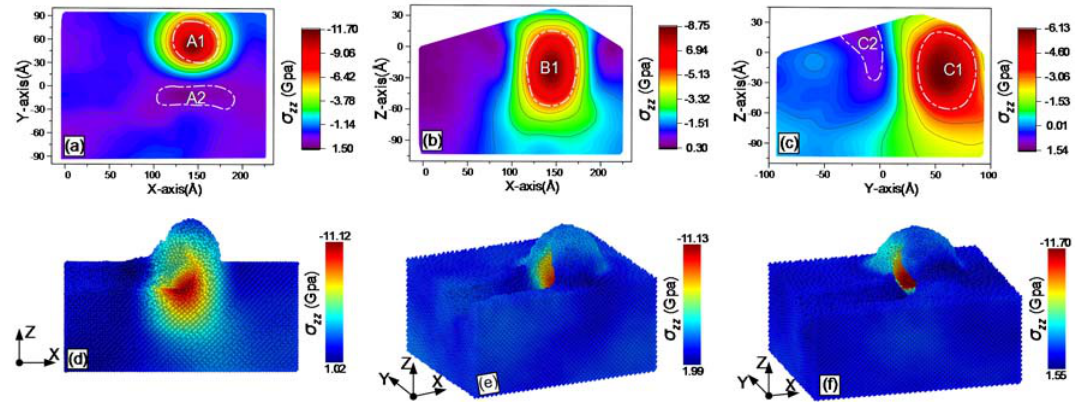
Figure 11. Snapshots of the normal stress σ zz after the atomic-scale curve grinding: ( a ) on X–Y plane; ( b ) on X–Z plane; ( c ) on Y–Z planes; ( d ) at the front point of the arc, ( e ) at the rear of the arc; and ( f ) at the end of the tool.